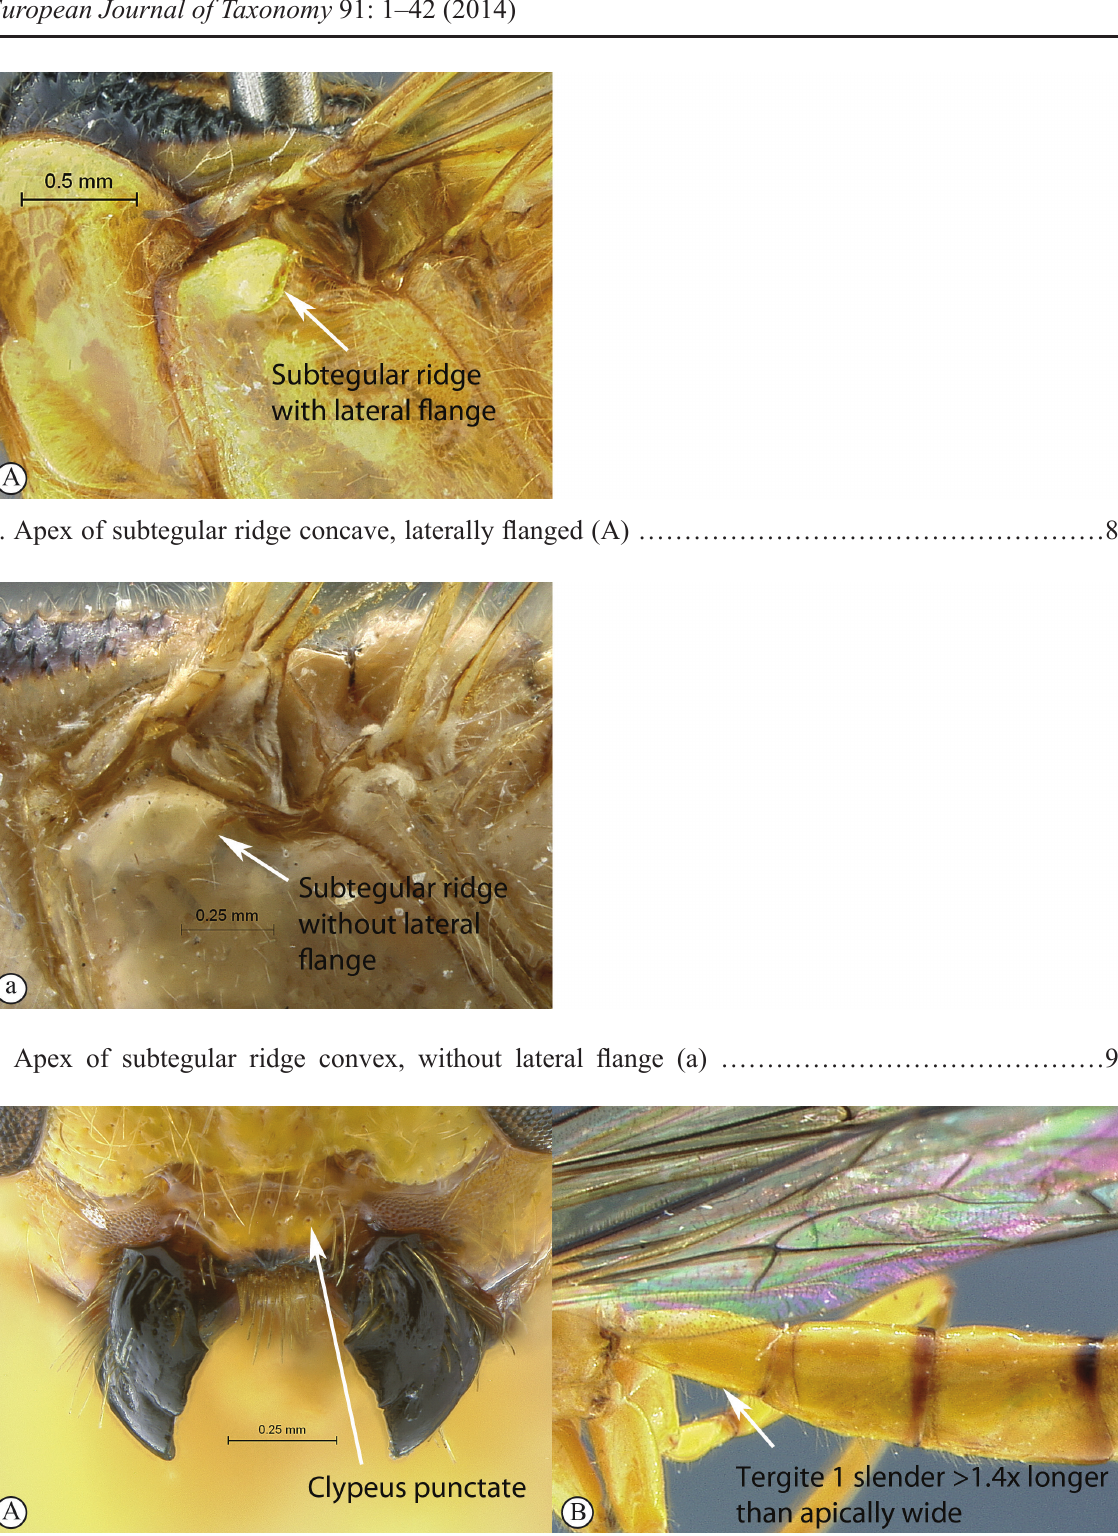
8. Clypeus punctate (A); tergite 1 of female slender, more than 1.4x longer than apically wide (B)